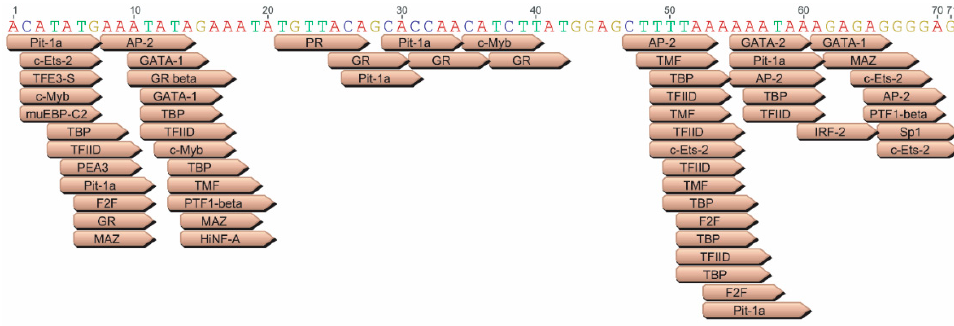
Figure 8. Transcription Factors Predicted to Bind to JE-71. A number of different transcription factors have been predicted to bind to the JE-71 sequence using the EMBOSS 6.5.7 tool tfscan and graphically presented by Geneious. Particularly promising putative transcription factors with multiple predicted binding sites include AP-2 (4 sites), glucocorticoid receptor (GR/GR beta, 5 sites), pituitary-specific positive transcription factor 1 (Pit-1A, 5 sites), and c-ETS-2 (4 sites).